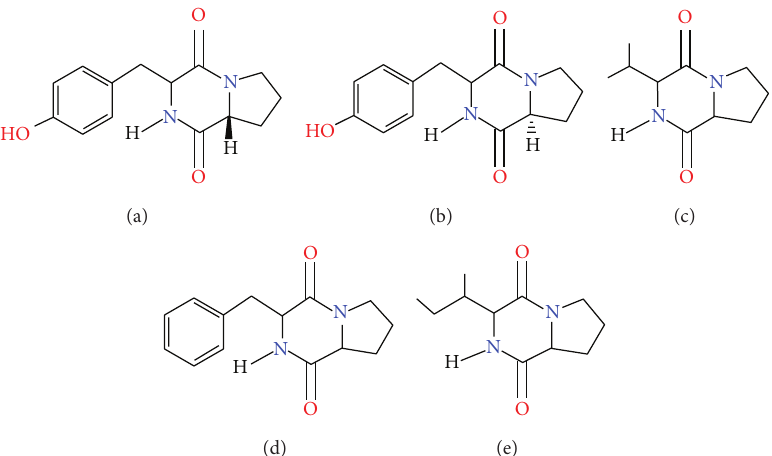
Figure 1: Structure of DKPs known to be produced by the archaeon H. hispanica . (a) Cyclo(D-prolyl-L-tyrosine), (b) cyclo(L-prolyl-L- tyrosine), (c) cyclo(L-prolyl-L-valine), (d) cyclo(L-prolyl-L-phenylalanine), and (e)